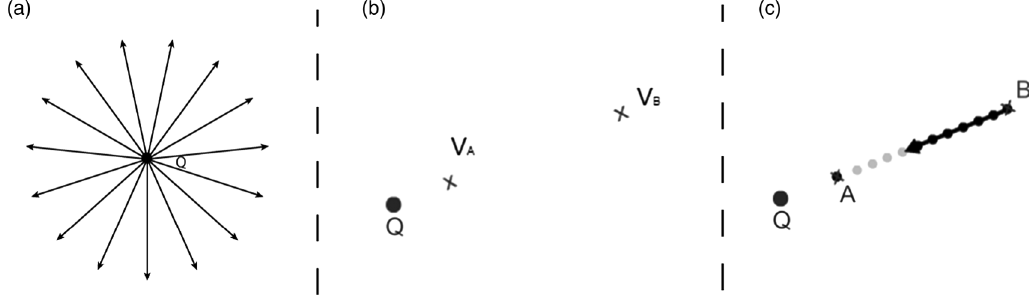
FIG. 5. Visual representations frequently used in teaching electric potential. (a) Line and arrow representation of electric field created by a point charge Q . (b) Electric potential between two points indicated by crosses and labeled V A and V B , respectively. (c) Snapshot of an animation representing the integral from point B to point A . The integral is represented by a moving arrow going through multiple